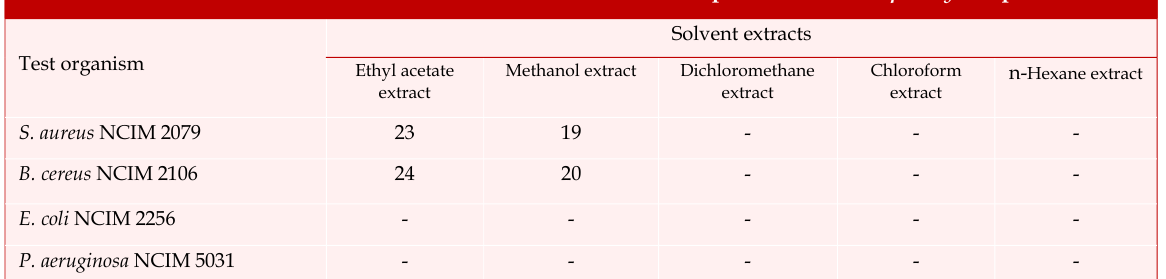
Effect of different solvents on the extraction of bioactive compounds from Streptomyces sp